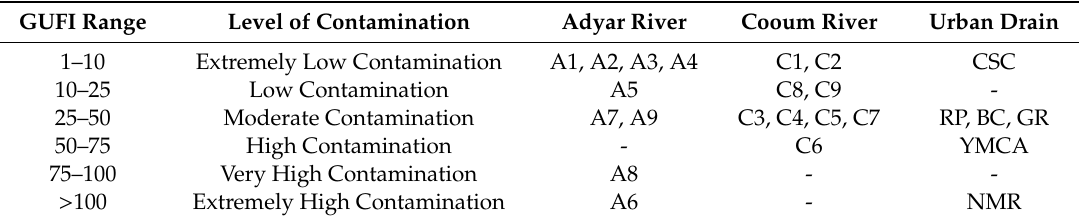
Table 3. Geochemical Urban Footprint Index (GUFI) classification in the river sediment of Chennai City. GUFI Range Level of Contamination Adyar